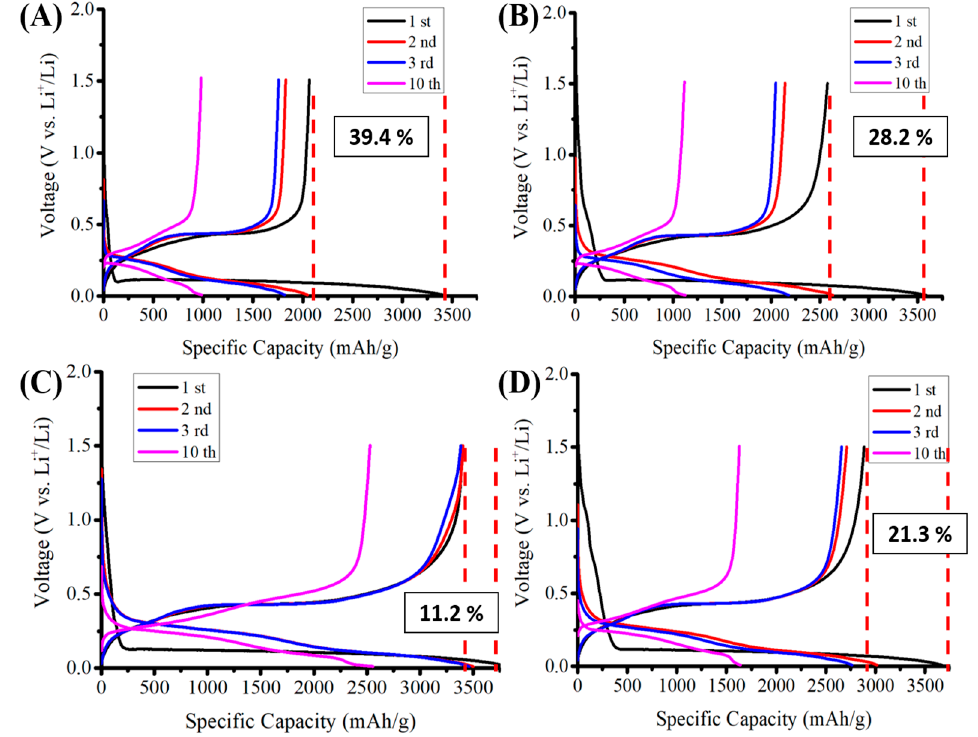
Figure 4. Capacity vs. voltage (Li + /Li) of anodes made of ( A ) silicon flakes:Super P:CMC/SBR = 70%:10%:20% by weight, ( B ) silicon flakes:KB:CMC/SBR = 70%:10%:20% by weight, ( C ) silicon flakes:Super P:CMC/SBR = 70%:10%:20% by weight after pyrolysis, and ( D ) silicon flakes:KB:CMC/SBR = 70%:10%:20% by weight after pyrolysis.